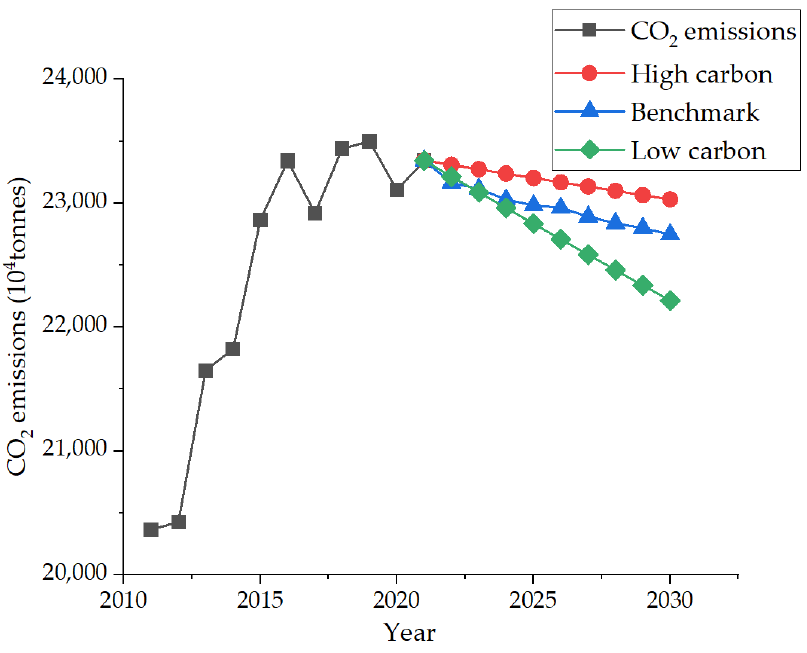
Figure 12. Three CO 2 emissions development scenarios.